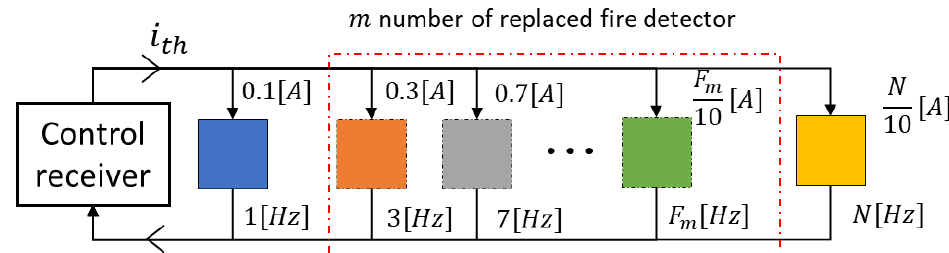
Figure 3. Automatic address